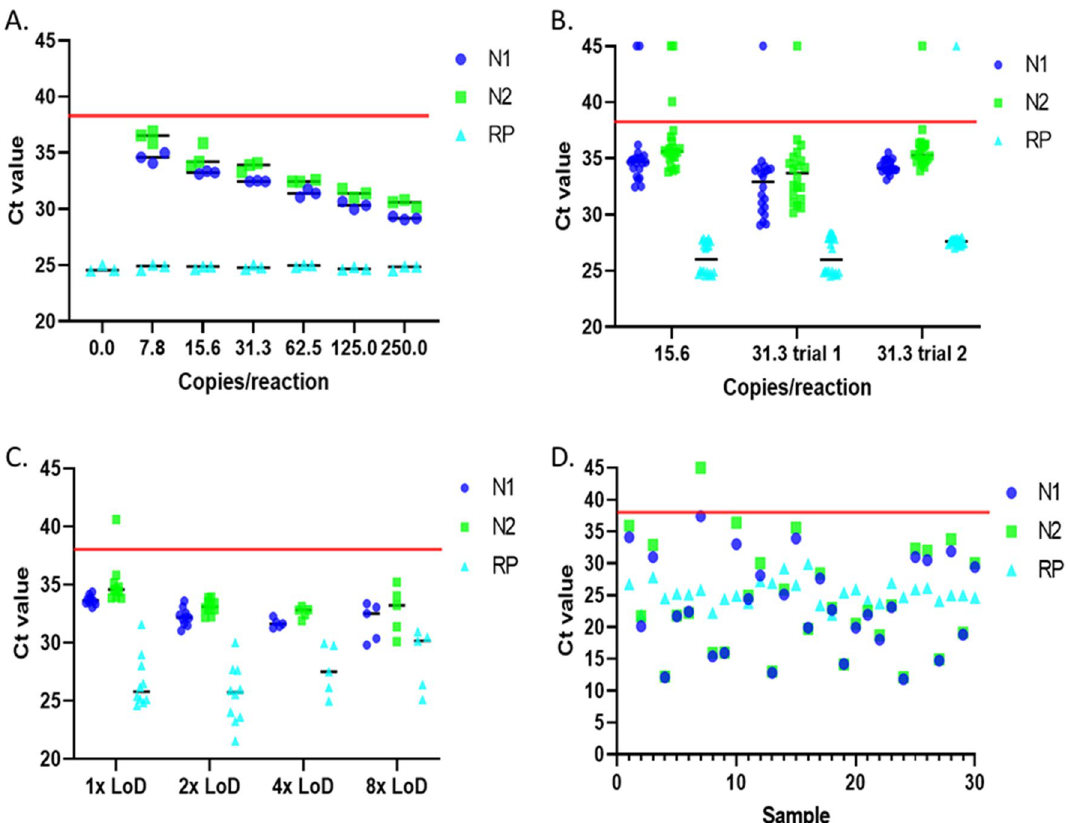
Figure 1. SARS-CoV-2 RT-PCR assay development. Assay detects 2 sequences (N1 and N2) from SARS-CoV-2 and a human RNA (RP) as an internal extraction control. ( A ) Rough Limit of detection (LoD) of positive control RNA spiked into pooled negative nasopharyngeal samples at known copy numbers. Black lines represent the mean, N = 3. The red line denotes the Ct cutoff (38) for a positive result. ( B ) Comprehensive LoD study of positive control RNA spiked into pooled negative nasopharyngeal samples at known copy numbers. These studies defined 31.25 copies/reaction as the LoD. Black lines represent the mean, N = 20. The red line denotes the Ct cutoff (38) for a positive result. ( C ) Mock clinical samples created by spiking known concentrations of synthetic SARS-CoV-2 RNA into individual negative nasopharyngeal samples. Samples were blinded to assay personnel. N = 10 for 1 × and 2 × LoD. N = 5 for the 4 × and 8 × LoD. The red line denotes the Ct cutoff (38) for a positive result. ( D ) 30 positive clinical confirmation samples. Samples were blinded to assay personnel and run concurrently with negative samples. The red line denotes the Ct cutoff (38) for a positive result. Samples with no signal detected during the real time RT-PCR are shown at Ct 45 in the